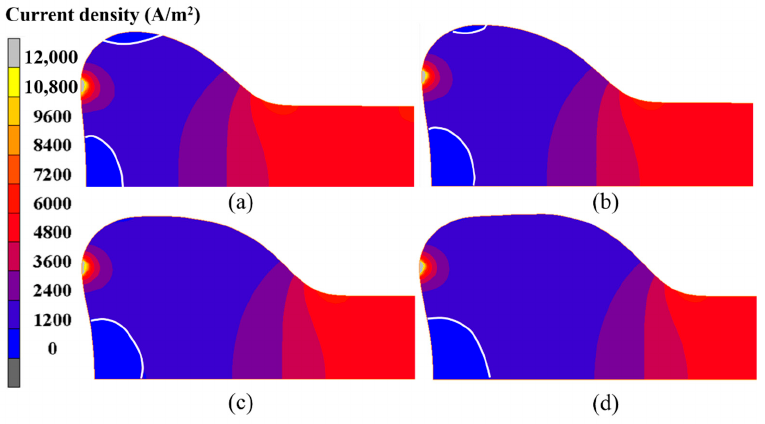
Figure 17. Current density distributions of the billet at different moments of the electric upsetting process: ( a ) 400 s, ( b ) 450 s, ( c ) 500 s and ( d ) 550